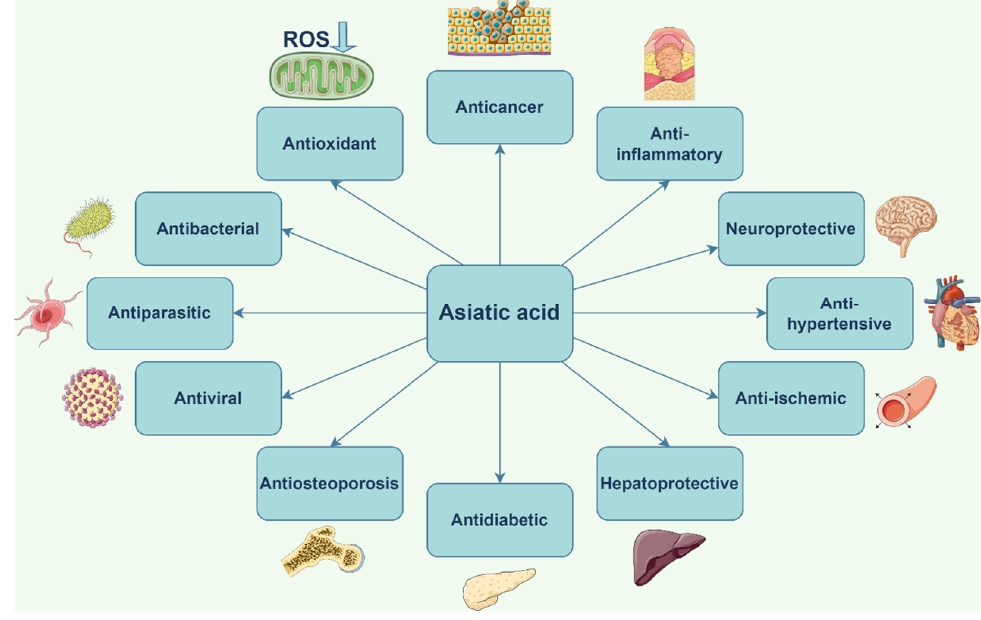
Figure 4. Biological activities of asiatic acid.